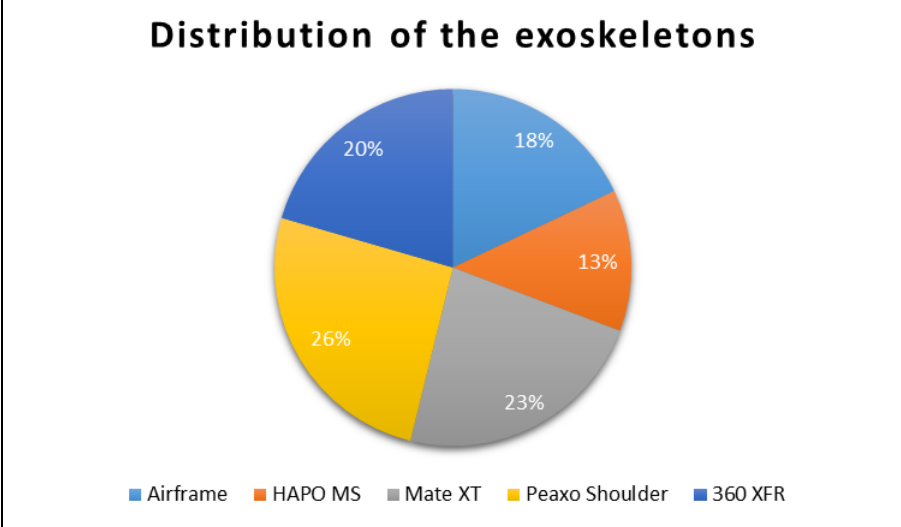
Figure 3. Illustration of the distribution of the exoskeleton use. Fraunhofer IPA.